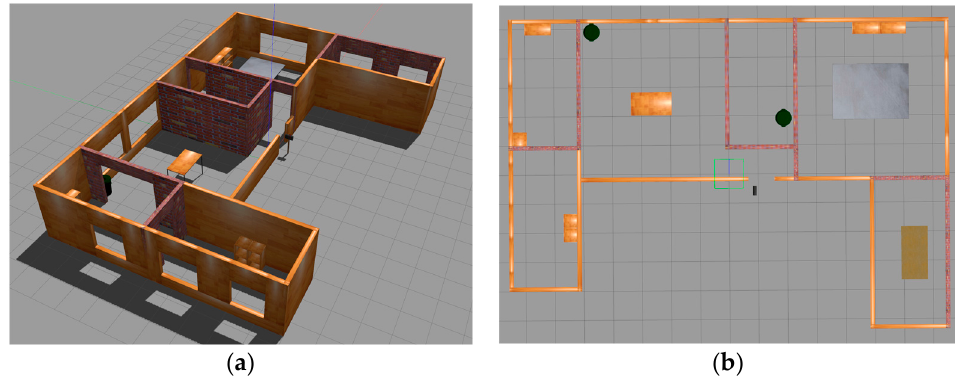
Figure 3. Simulated environment. ( a ) Perspective view. ( b ) Top-down view.